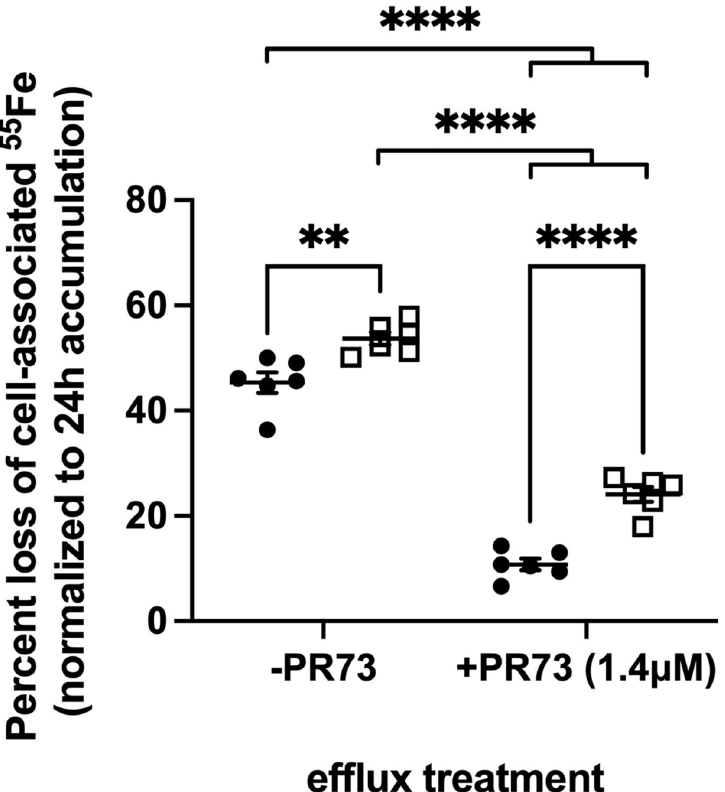
Fig 11. PBT434 stimulates ferroportin-dependent 55 Fe 2+ efflux. hBMVEC were loaded with 1 μ M 55 Fe 2+ at 37˚C for 24h in the absence (-PR73) or presence of mini-hepcidin PR73 (+PR73, 1.4 μ M). Iron efflux was then initiated in efflux medium alone (control, closed circles), or media containing PBT434 (20 μ M, open squares). The amount of 55 Fe lost from the cells after 6h incubation was quantified; the data are presented as the percent loss of the initial cell-associated 55 Fe 2+ . Data are represented as mean ± SEM, n = 6 biological replicates/condition. Statistical significance was determined using two-way ANOVA and Tukey’s multiple comparison test. �� , p < 0.01; ���� , p < 0.0001 compared to control or as indicated.